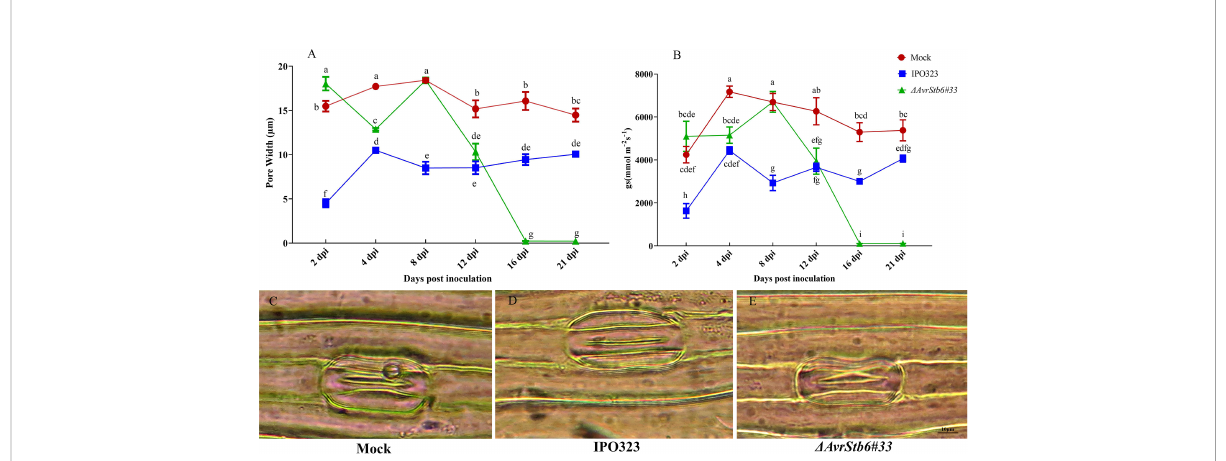
FIGURE 1 The effect of AvrStb6-Stb6 interaction on stomatal pore width and gas exchange. (A) Measuring the stomatal pore width of cv. Sha fi r inoculated by distilled water (Mock), the WT strain carrying the AvrStb6 (IPO323), and deleted mutant for AvrStb6 ( D AvrStb6#33 ); (B) estimating the g s ratio of the treated plants; (C) Microscopic picture of a stomata from a plant treated by distilled water (Mock: semi-open); (D) inoculated by IPO323 (closed), and (E) inoculated by D AvrStb6#33 (open). Data indicate mean ± SD (Standard Deviation) of twelve individual leaves derived from four biological samples. This assay was repeated independently twice. Different lowercase letters indicate statistically signi fi cant differences (P ≤